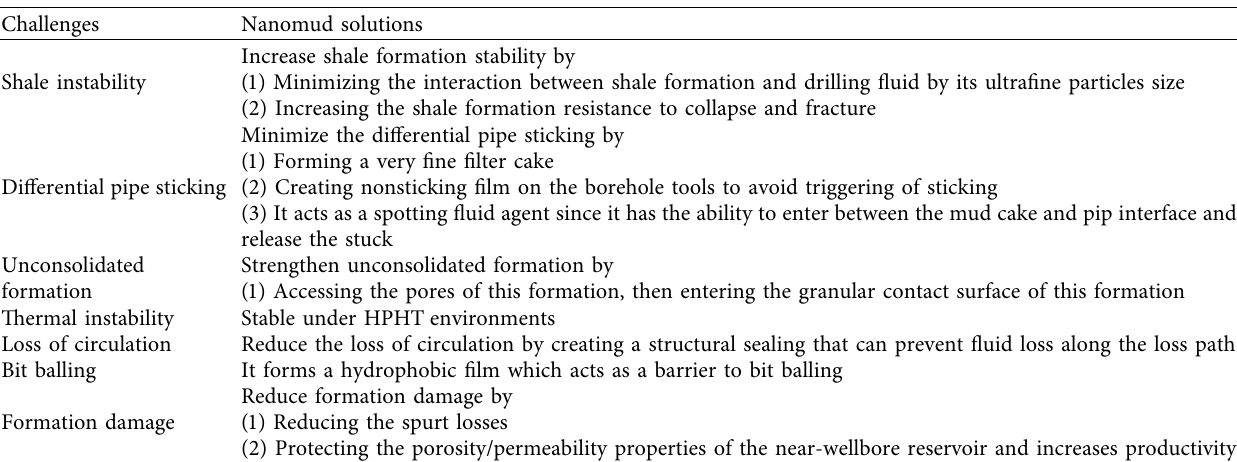
Table 1: Nanomud technical solutions.